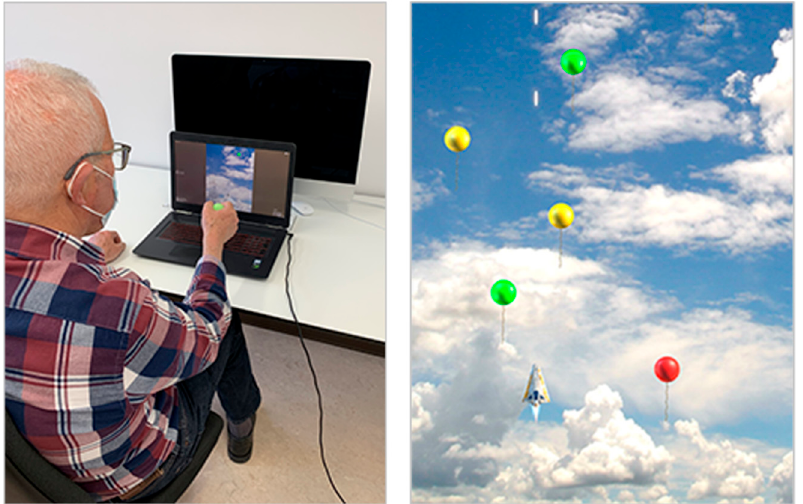
Figure 4. Participant playing Asteroid Shooter with the Smart Sensor Egg ( left ). Scenario of Asteroid Shooter game with the spaceship being controlled by the Smart Sensor Egg ( right ). The aim is to position the spaceship directly under the approaching targets (which are depicted as balloons in the lower difficulty levels; later levels feature asteroids as targets and include a space picture as the background image) and then to shoot them by squeezing the device.